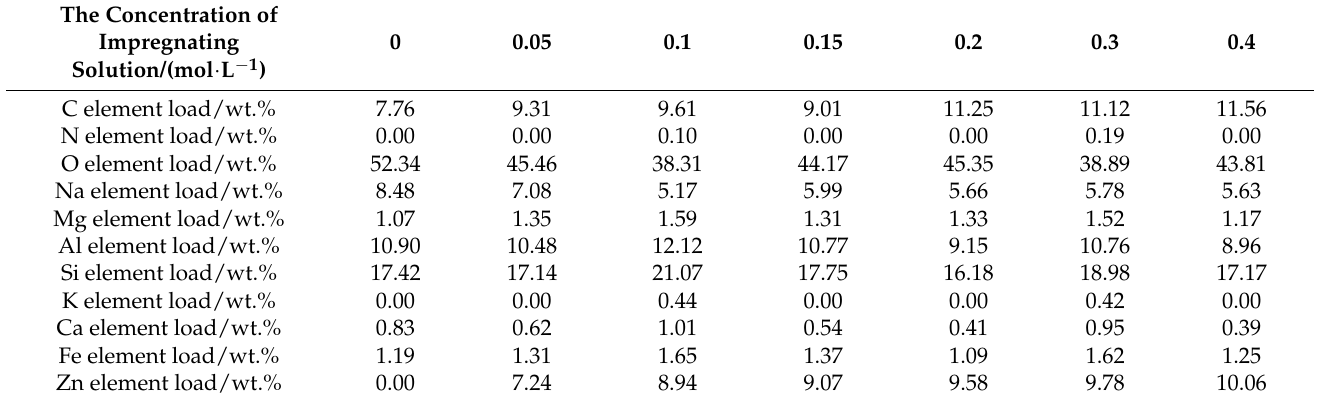
Table 3. Elemental composition after modification of 13X with different Zn(NO 3 ) 2 solution concen-